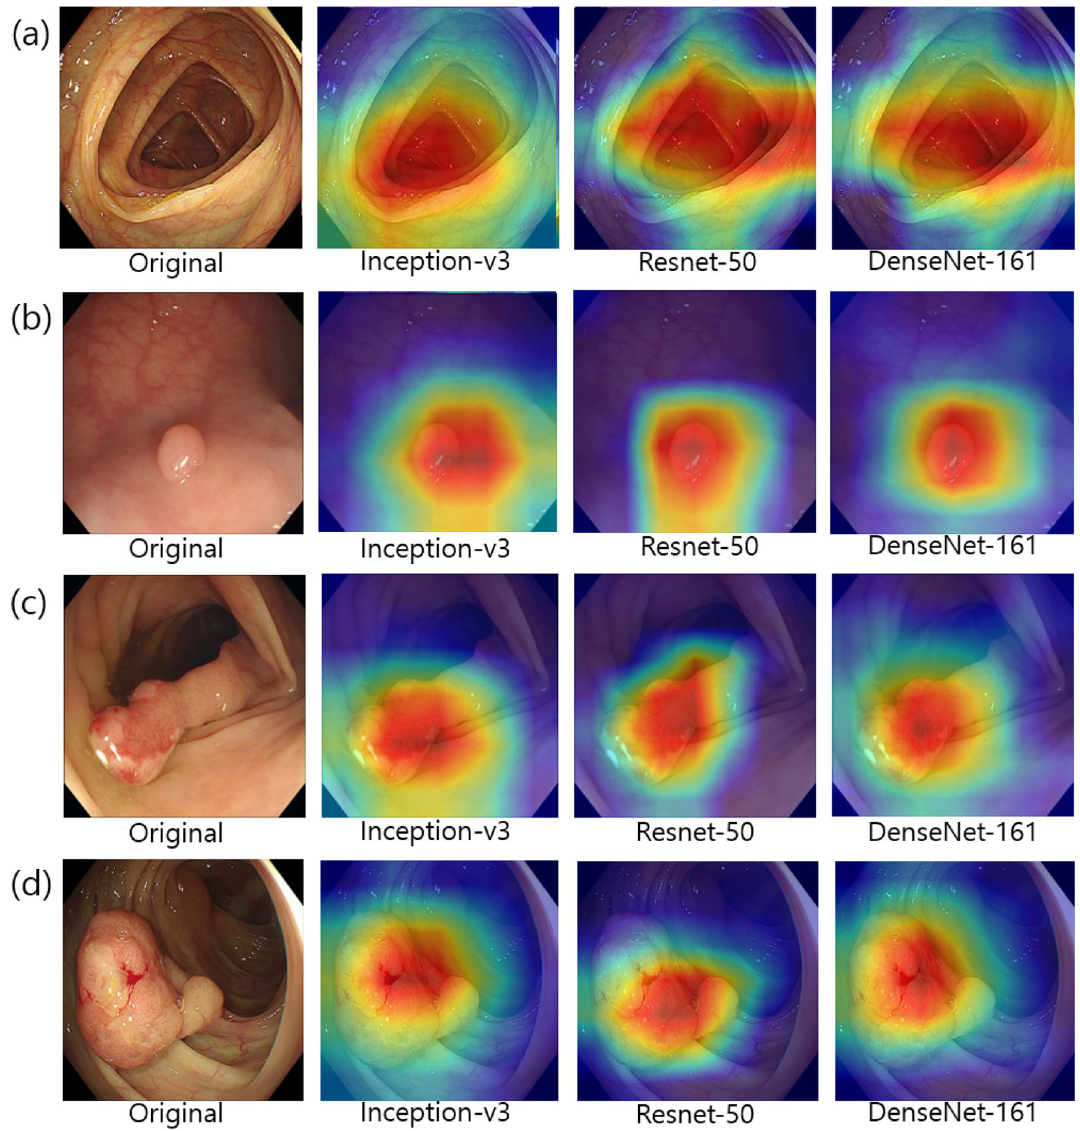
Figure 6. Classification activation maps using different convolutional neural network models in colonoscopic images. ( a ) normal, ( b ) low grade dysplasia, ( c ) high grade dysplasia, ( d ) adenocarcinoma.